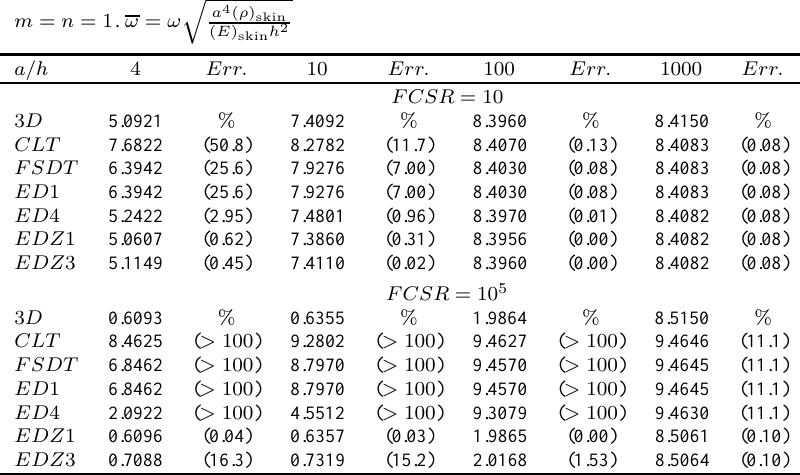
Table 2 Comparison of various theories to evaluate the fundamental frequency amplitude for the